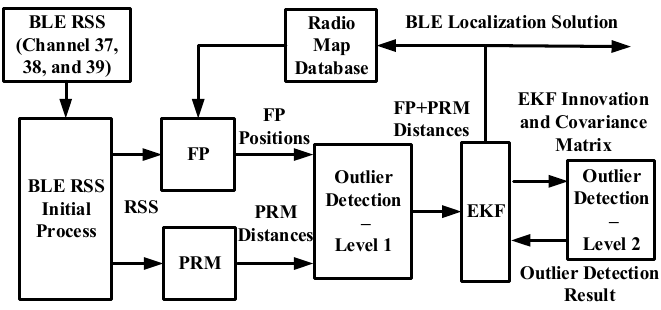
Figure 2. Overview of the smartphone-based indoor localization algorithm with BLE beacons.